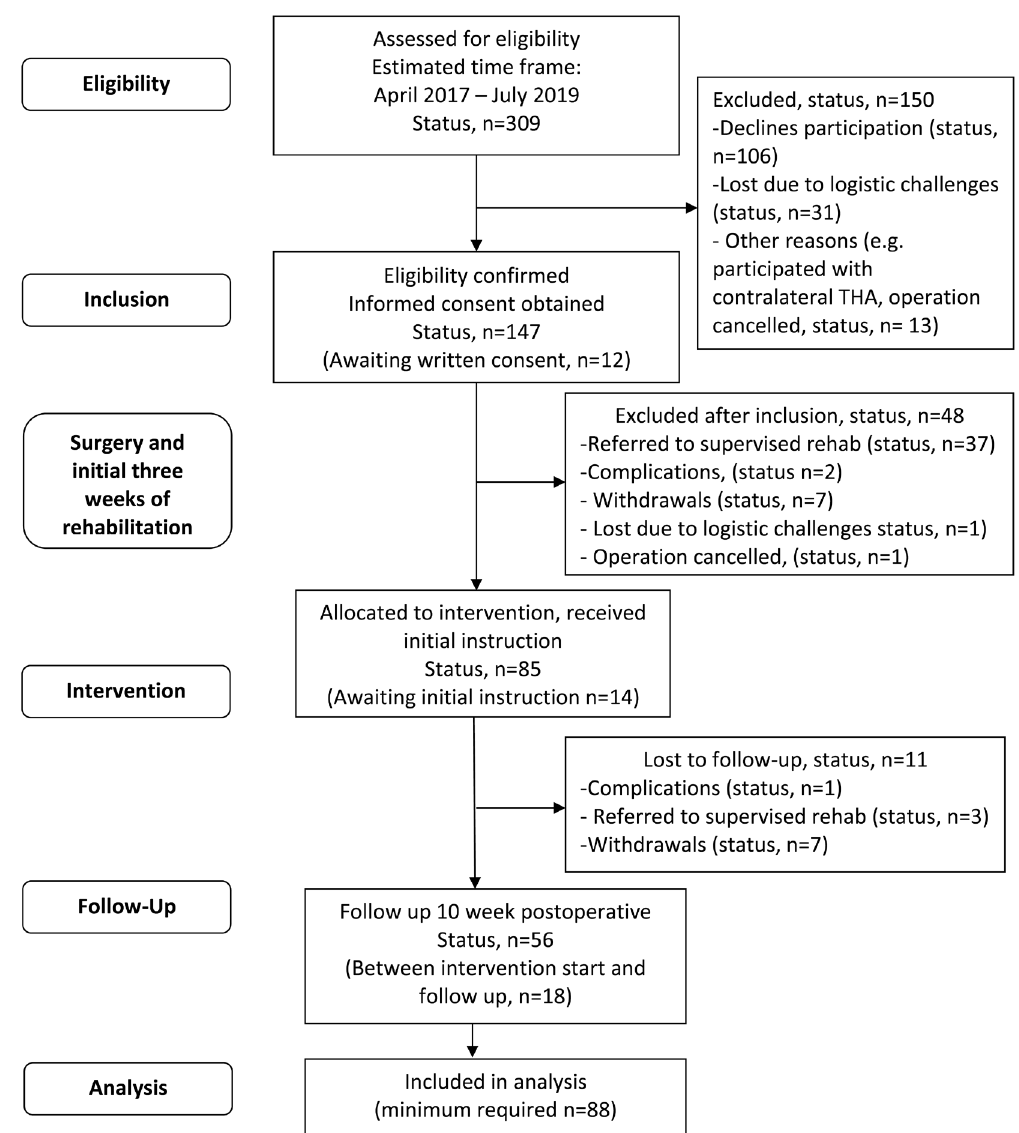
Figure 1. Estimated participant